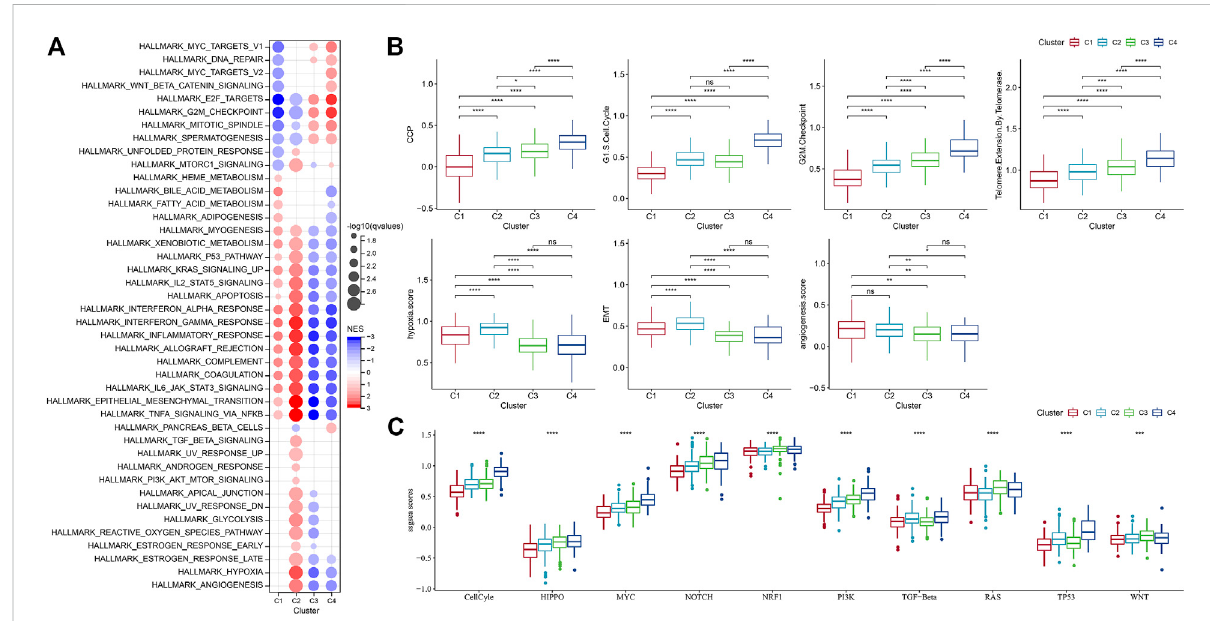
FIGURE 5 Differences in pathway enrichment fractions among different molecular subtypes. (A) GSEA analysis results from the TCGA-GBM cohort; (B) Differences in ssGSEA scores of cell senescence-associated pathways in the TCGA-GBM cohort; (C) Score differences of different molecular subtypes in 10 pathways related to tumor abnormalities in the TCGA-GBM